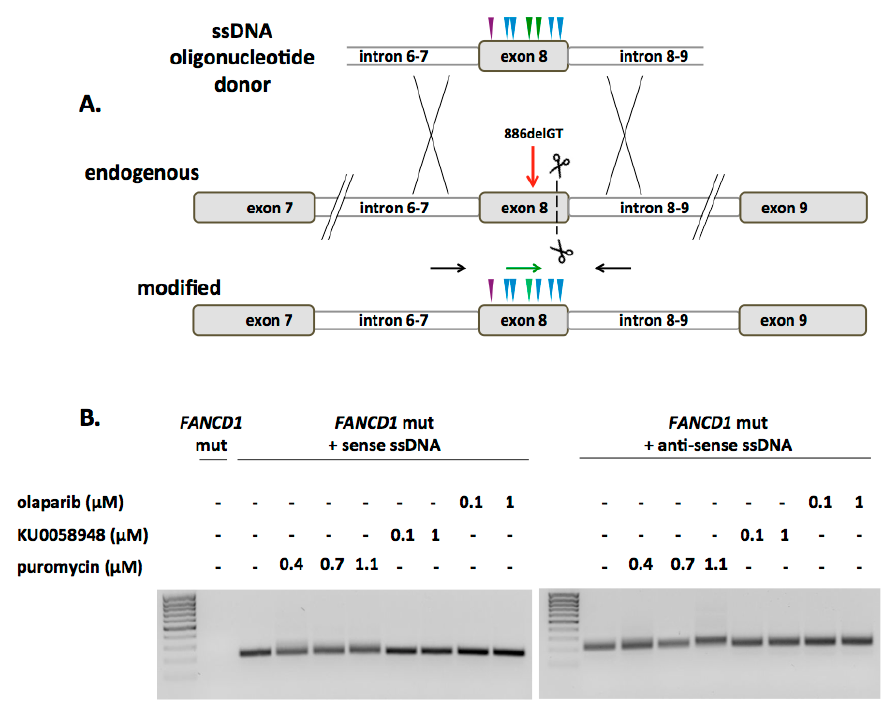
Figure 2. FANCD1 gene correction. ( A ) Gene correction experimental design. A single stranded oligonucleotide donor spanning exon 8 and adjacent intron sequence was designed to have polymorphic sequences. These polymorphisms prevent re-cutting of the donor (blue arrows), add the GT dinucleotide (green arrow), and insert a Hind III restriction site (purple arrow); ( B ) HDR screening. Cells were unselected or selected in bulk with 1 μ M olaparib, 1 μ M KU0058948, or 1.1 μ M puromycin. PCR with primers that are within the donor (green arrow) and outside the donor in exon 8 (black arrow in ( A ) were used to amplify the modified locus.